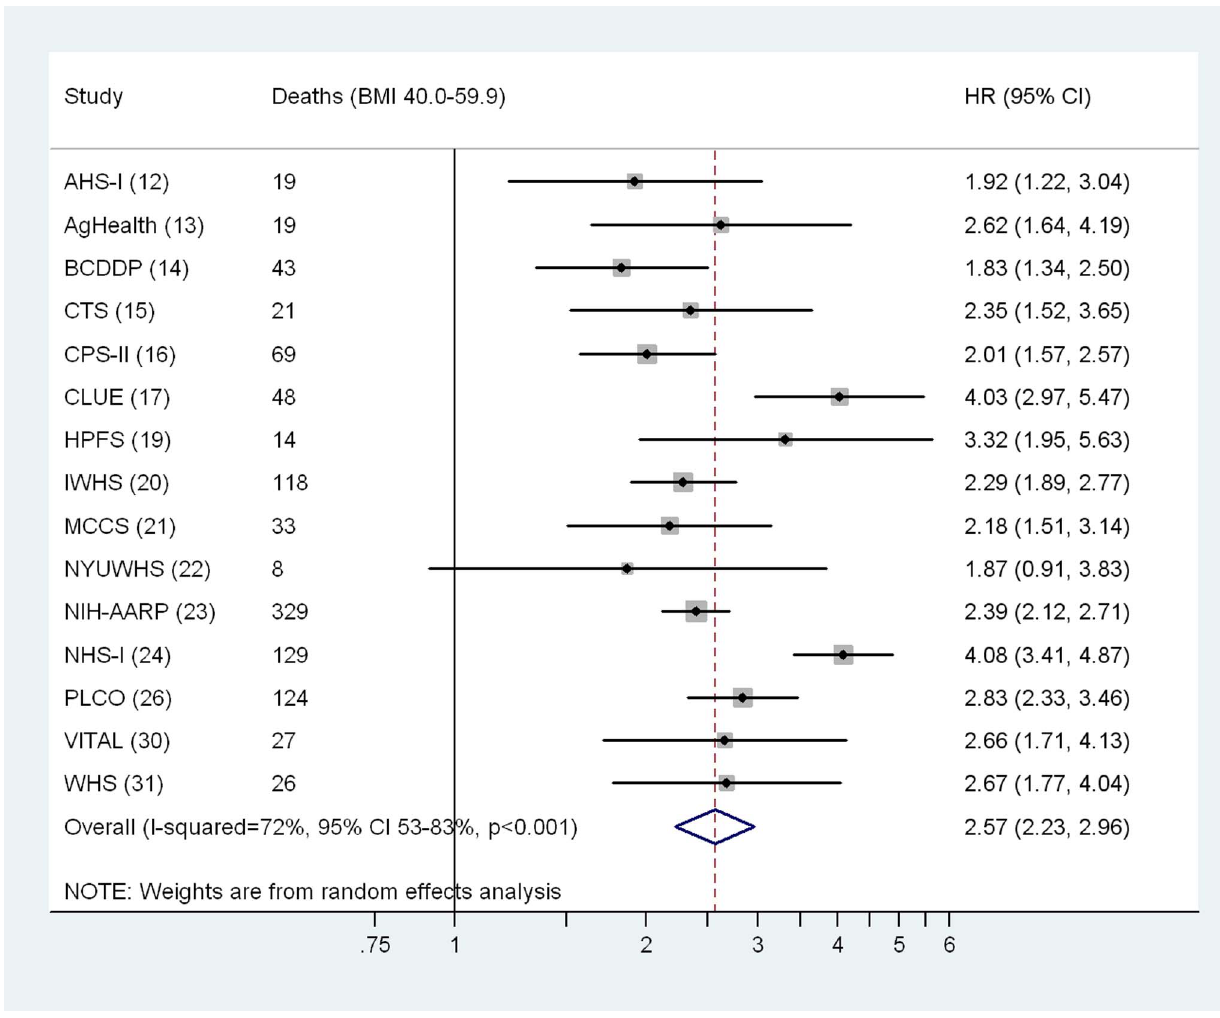
Figure 1. Cohort-specific and overall hazard ratios and 95% confidence intervals for BMI 40.0–59.9 kg/m 2 versus 18.5–24.9 kg/m 2 . Results for cohorts with fewer than five deaths in the BMI 40.0–59.9 kg/m 2 group are not shown. Cohort-specific models use attained age as the underlying time metric, and are adjusted for sex, race/ethnicity (white [all participants in the Swedish and Australian cohorts were coded as white], black, Asian/Pacific Islander, Hispanic, other/unknown), education (high school or less, post–high school, college, unknown), alcohol intake (grams of ethanol per day: 0, . 0 to , 10, $ 10, unknown), and physical activity level (cohort-specific tertiles corresponding to low, medium, and high). Random effects models were used to calculate overall (pooled) HRs and 95% CIs. The cohort acronyms are identified in Table 1, and references are given in parentheses.